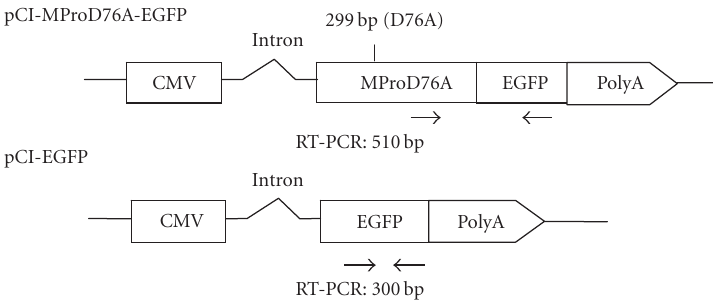
Figure 1: Schematic illustration representing plasmids used in this study. The mutant myostatin propeptide (MProD76A) gene was cloned into the pCIneo plasmid containing a CMV promoter, chimeric intron and simian virus 40 (SV40) poly (A) sequence. The 5 (cid:3) primer ( → ) and the 3 (cid:3) primer ( ← ) are in the coding area of MProD76A and EGFP, respectively. A 510-bp band indicated mRNA expression of MProD76A- EGFP. A 300-bp band indicated mRNA expression of control EGFP.